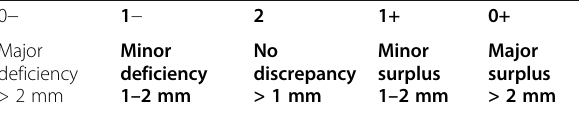
Table 1 Modified PES-3 (mPES-3); in case of a deficiency, a minus sign, and in case of a surplus, a plus sign is added behind the original PES-3 score Modified PES-3 (mPES-3): level of soft-tissue margin versus refer- ence tooth